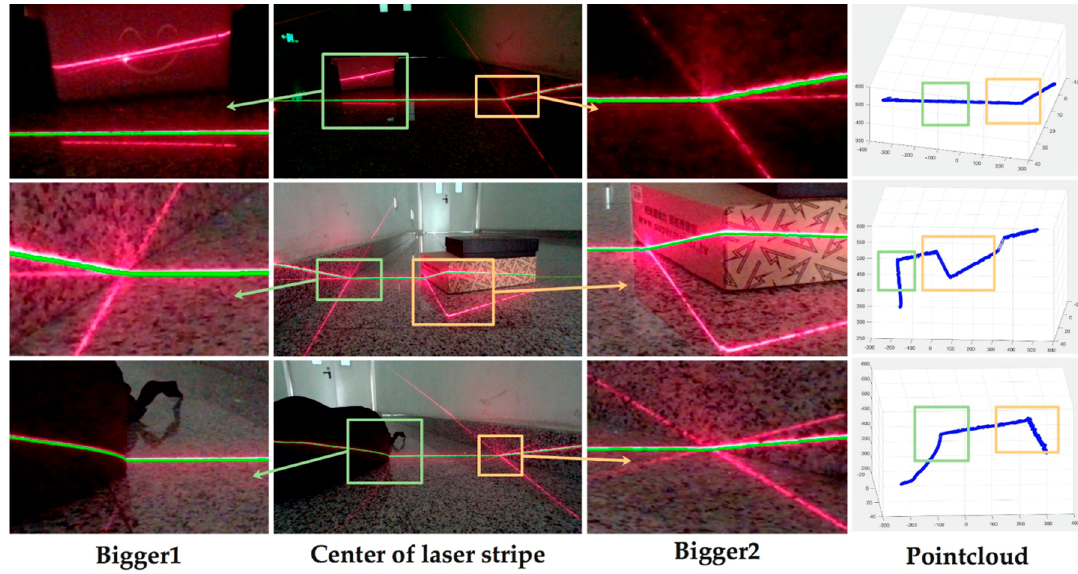
Figure 12. Point clouds reconstructed. The enlarged region in the left is highlighted in the right.